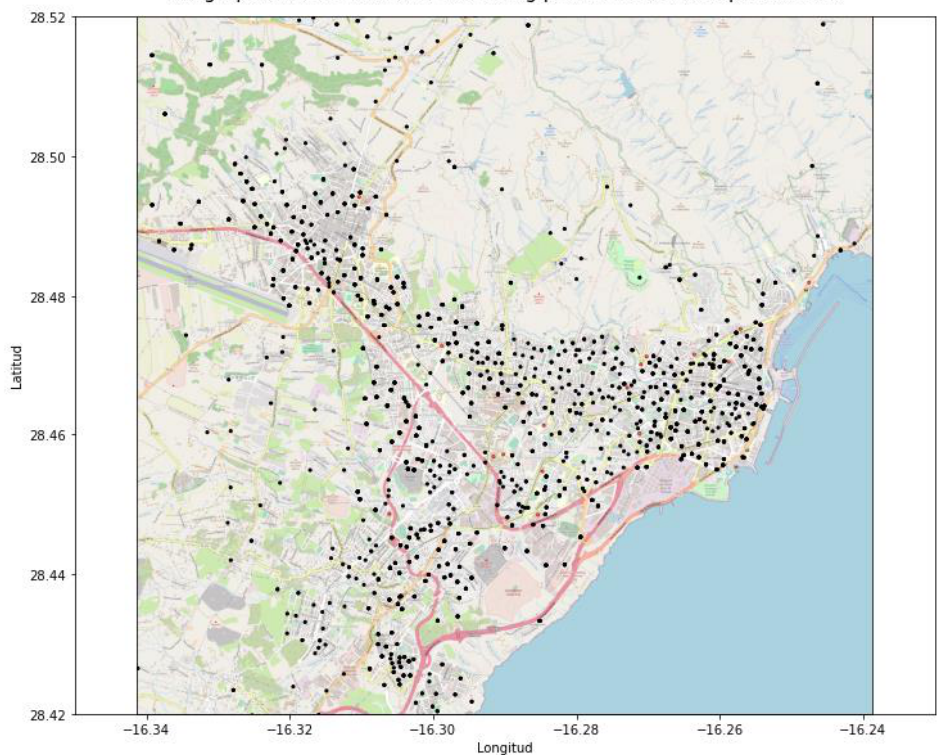
Figure 18. Distribution of charging points in the metropolitan area of Tenerife with each black dot representing a charging point.